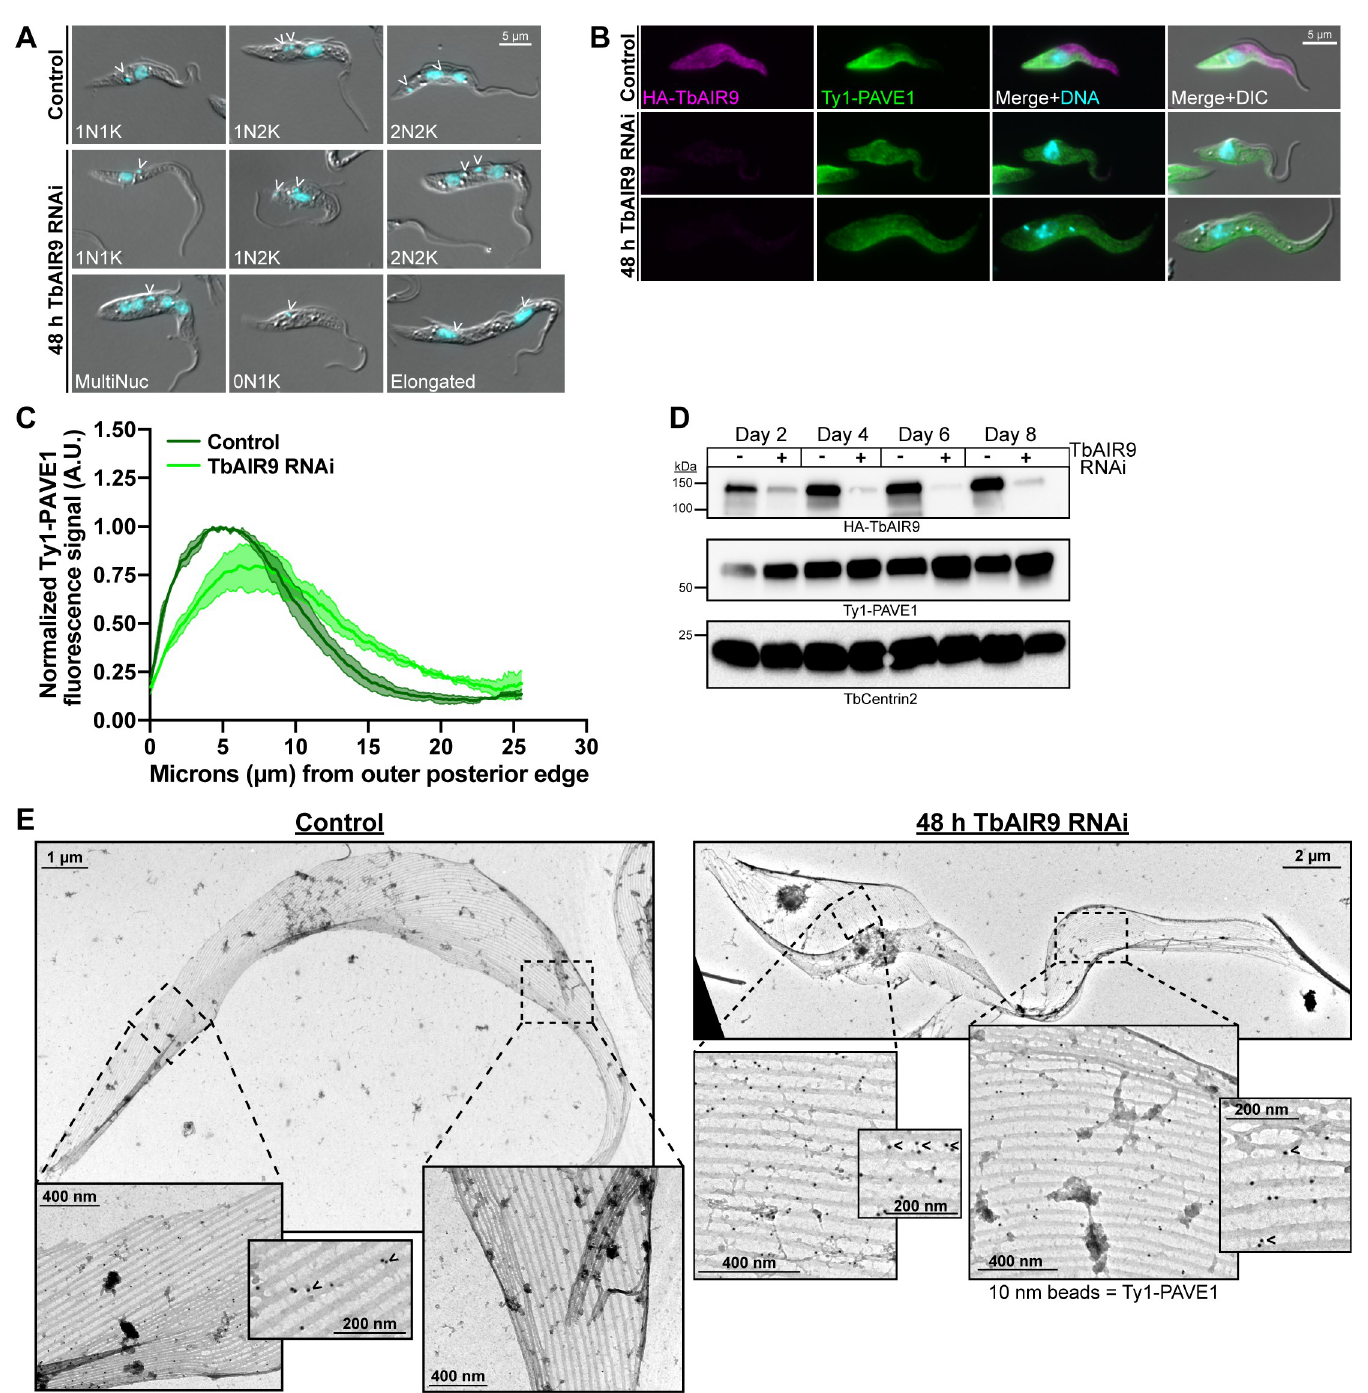
Fig 7. TbAIR9 maintains PAVE1 at the cell posterior. (A) Control and TbAIR9 RNAi cells were fixed in paraformaldehyde after 2 d of TbAIR9 depletion. Images are representative morphologies in control and TbAIR9 RNAi conditions. The epimastigote-like morphotype and elongated cell bodies were common in cells depleted of TbAIR9, as previously reported [35]. Open arrowheads indicate the kinetoplast. (B) Control and TbAIR9 RNAi cells were fixed in paraformaldehyde and stained after 2 d of TbAIR9 depletion. Ty1-PAVE1 signal is no longer maintained at the posterior and ventral edge. (C) The fluorescence signal intensity of Ty1-PAVE1 was measured along the ventral side of control and TbAIR9 RNAi cells after 2 d of TbAIR9 depletion. The signal intensities were normalized to the maximum control intensity, averaged, and plotted with the S.D. 50 1N1K cells in both control and TbAIR9 RNAi conditions from N = 3 independent biological replicates were measured. Ty1-PAVE1 signal is more evenly distributed throughout the array in TbAIR9 depleted cells than in control cells. (D) TbAIR9 RNAi was induced and lysates were collected every 48 h from control and TbAIR9 depleted cells. Lysates were separated by SDS-PAGE and transferred to nitrocellulose for western blotting.